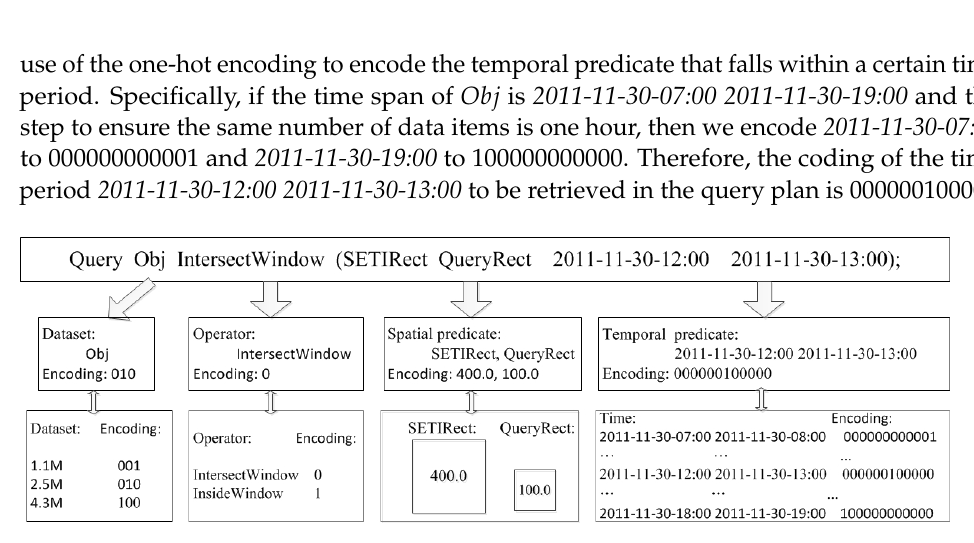
Figure 2. Example of feature extraction and